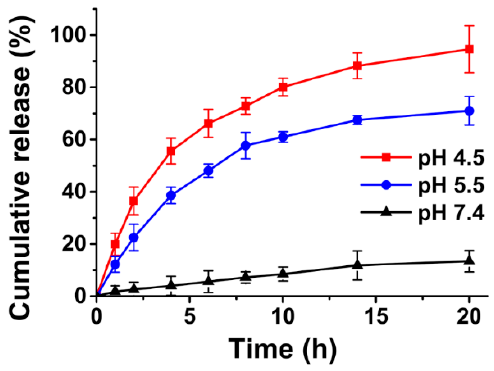
Figure 4. Cumulative release profiles of IFN from MPLL- alt -PEG at various pH.